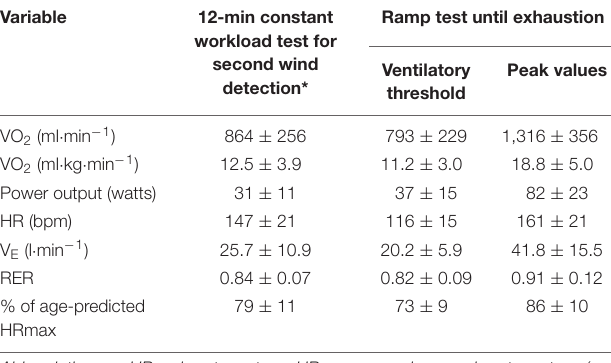
TABLE 1 | Physiological responses to the second wind and ramp tests in all participants ( n =